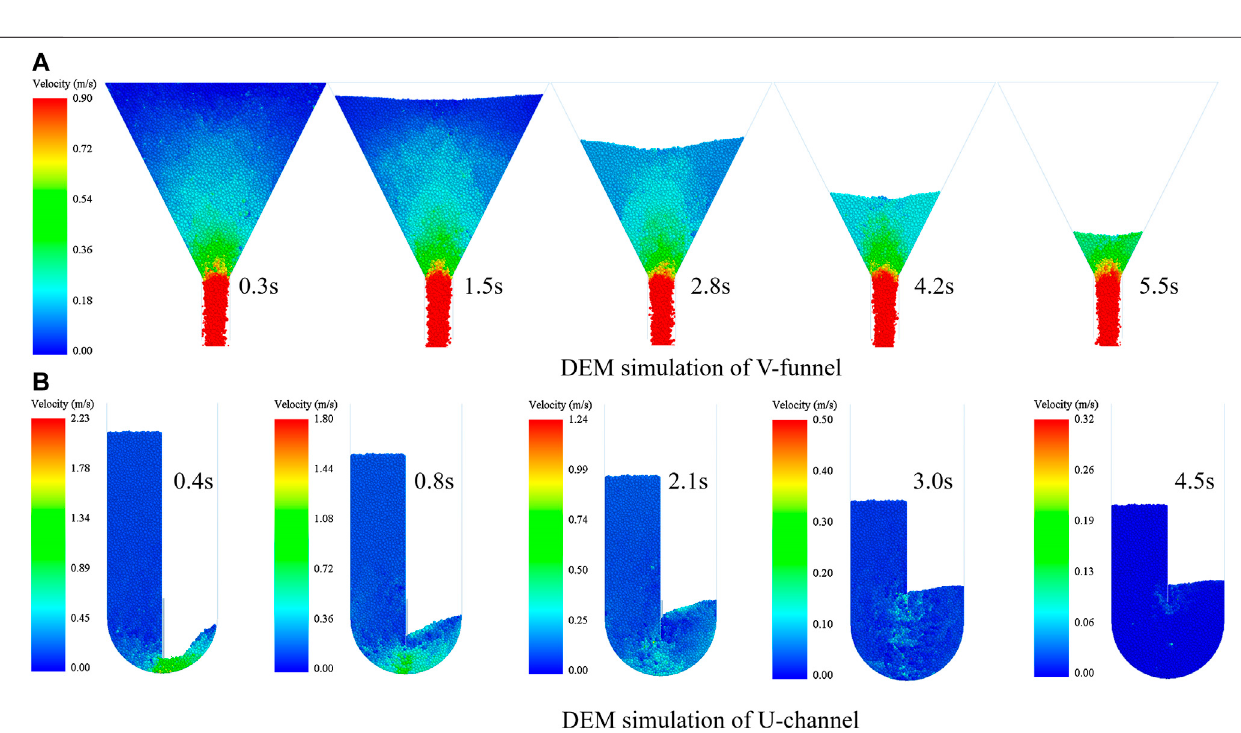
Frontiers in Materials |